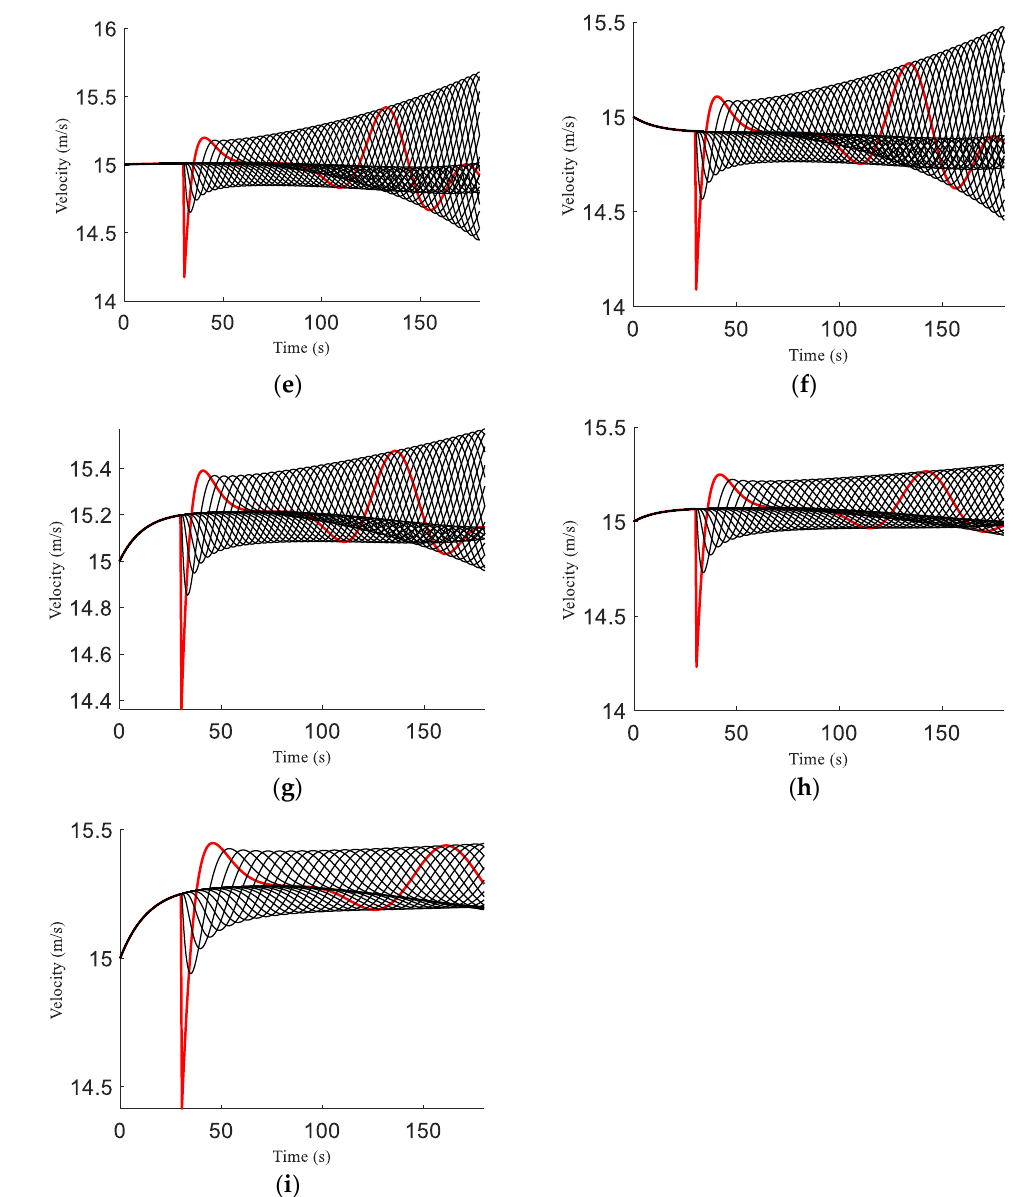
Figure 1. The velocity of the ID and proposed models with an initial equilibrium velocity of 15 m/s: ( a ) ID model, 𝛿 = 1 ; ( b ) ID model, 𝛿 = 4 ; ( c ) ID model, 𝛿 = 20 ; ( d ) proposed model, 𝛼 = 0 ; ( e ) pro- ( a ) ID model, δ = 1; ( b ) ID model, δ = 4; ( c ) ID model, δ = 20; ( d ) proposed model, α = 0; posed model, 𝛼 = 0.3 ; ( f ) proposed model, 𝛼 = 0.55 ; ( g ) proposed model, 𝛼 = 0.7 ; ( h ) proposed ( e ) proposed model, α = 0.3; ( f ) proposed model, α = 0.55; ( g ) proposed model, α = 0.7; model, 𝛼 = 0.8 ; ( i ) proposed model, 𝛼 = 0.9 . ( h ) proposed model, α = 0.8; ( i ) proposed model, α =